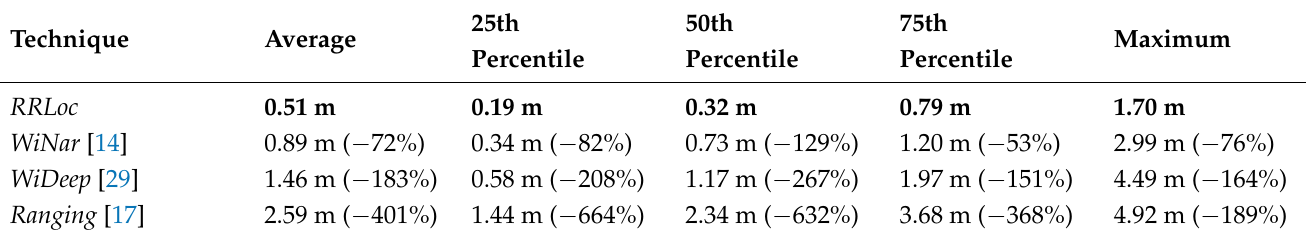
Table 4. The localization error percentiles in Office testbed.